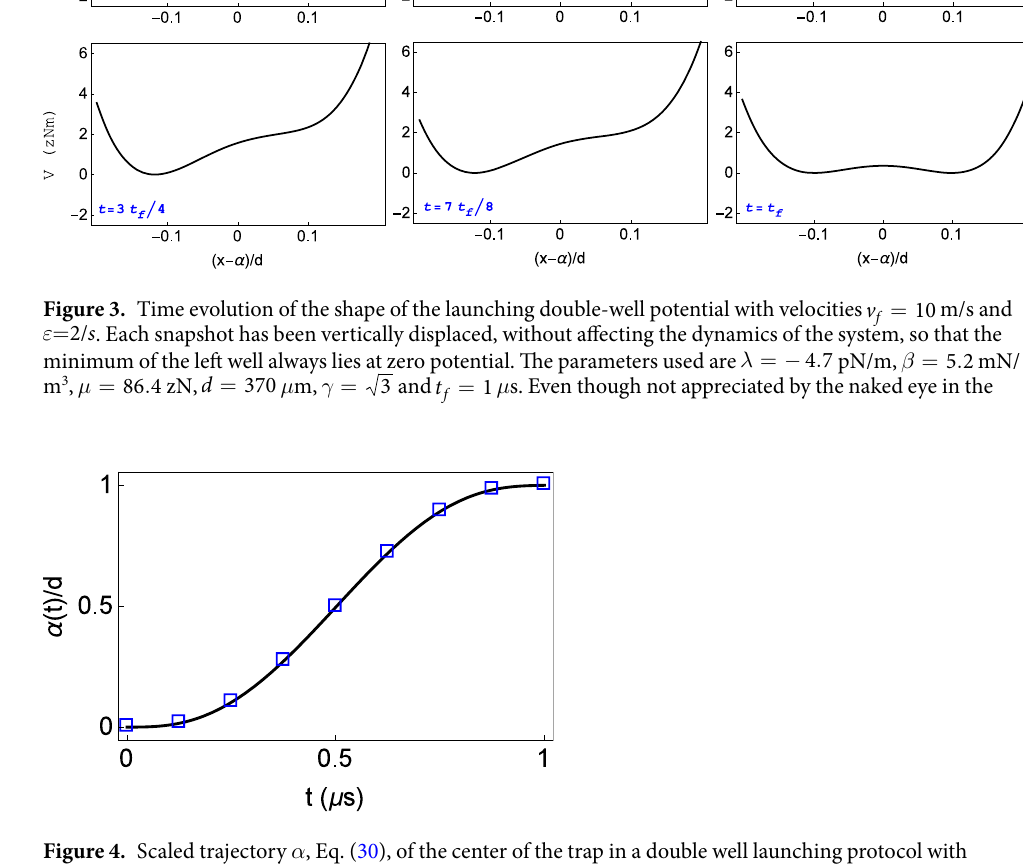
μ s, and velocities f